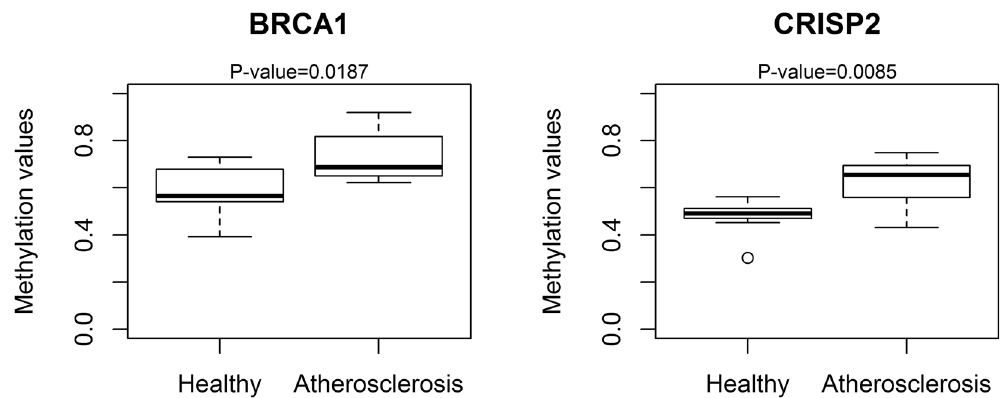
Figure 7. MassARRAY EpiTYPER validation of BRCA1 and CRISP2 . The mean methylation values of each measured region are represented in boxplots. The student t-test was used to calculate the significance of the methylation difference between healthy and atherosclerotic blood